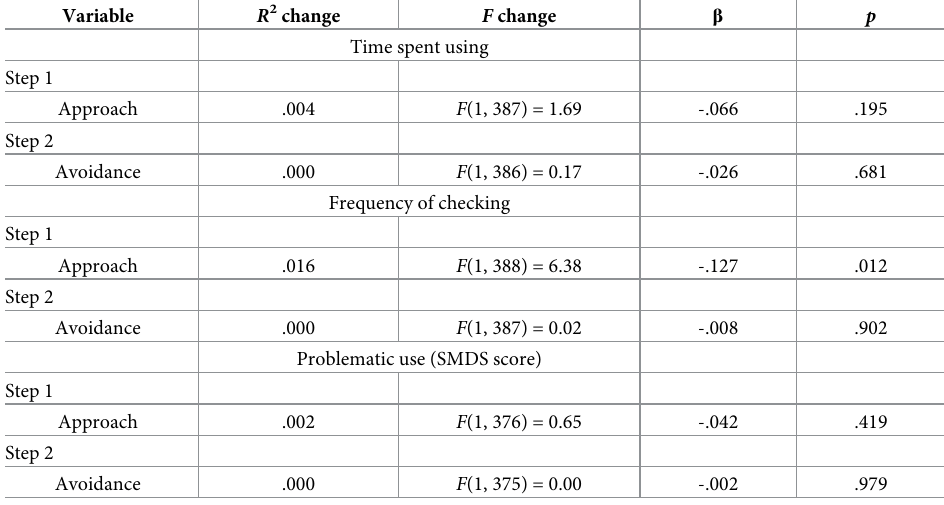
Table 1. Summary of regression analyses for the prediction of problematic use, frequency of checking and time spent on SNSs from approach and avoidance